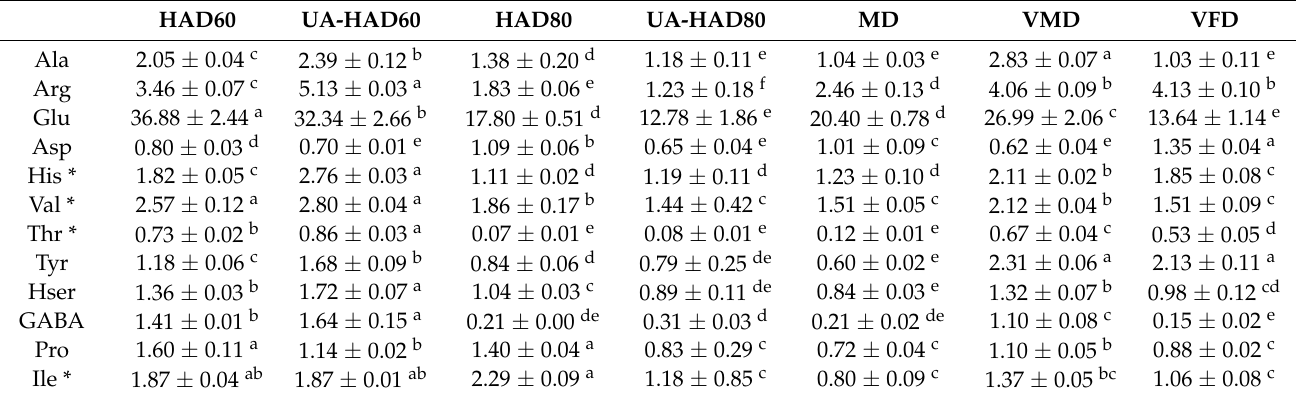
Table 2. The content of free amino acids of O. raphanipes subjected to different drying methods (mg/g dry